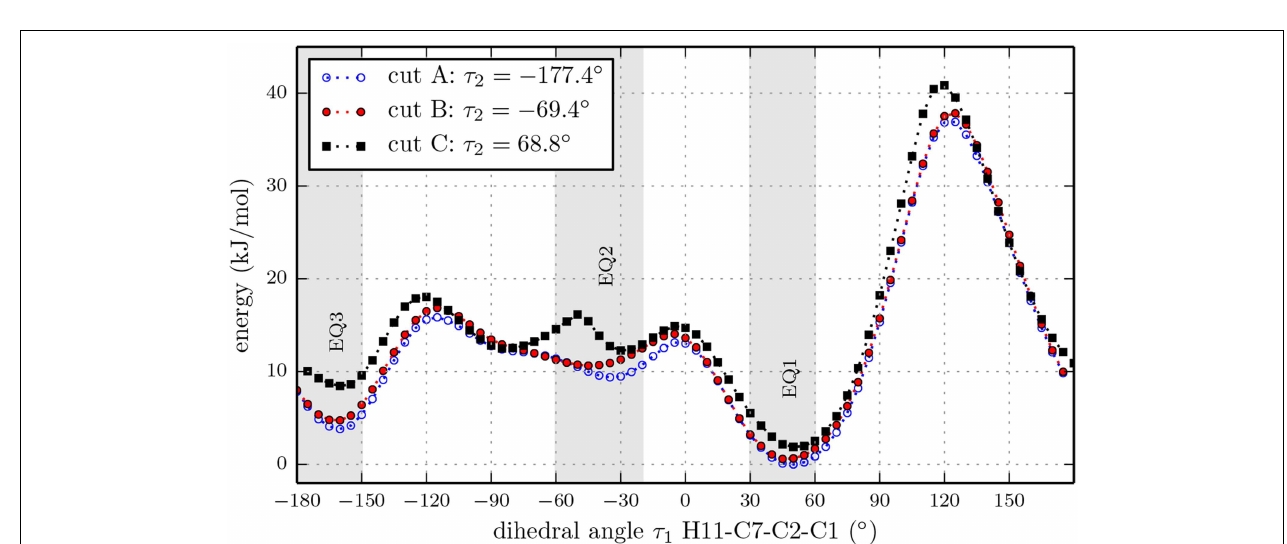
FIGURE 5 | Relaxed potential energy scans for the rotation of the isopropyl group of (-)-menthol with fixed orientations of the hydroxyl group at dihedral angles τ 2 = [ − 177 . 4 , − 69.4,68.8] ◦ (H12-O-C1-C2) according to the marks in Figure 4, at the